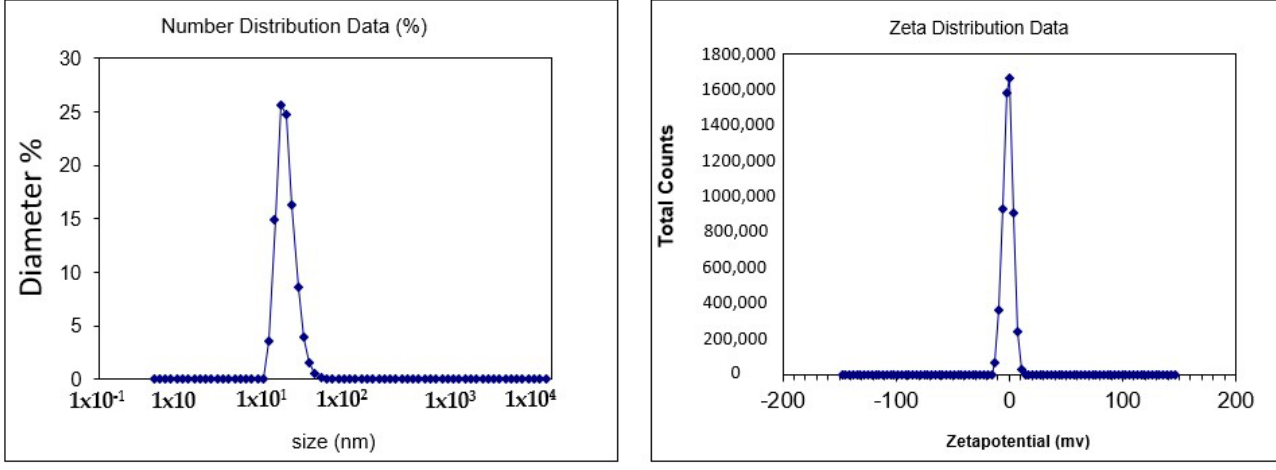
Figure 2. Shows the size and zeta potential of